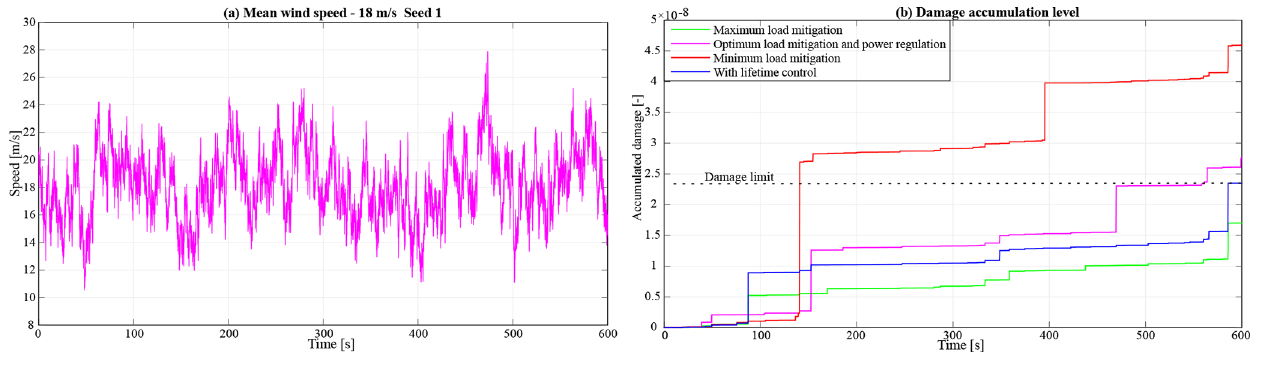
Figure 6. Adaptive lifetime control performance.